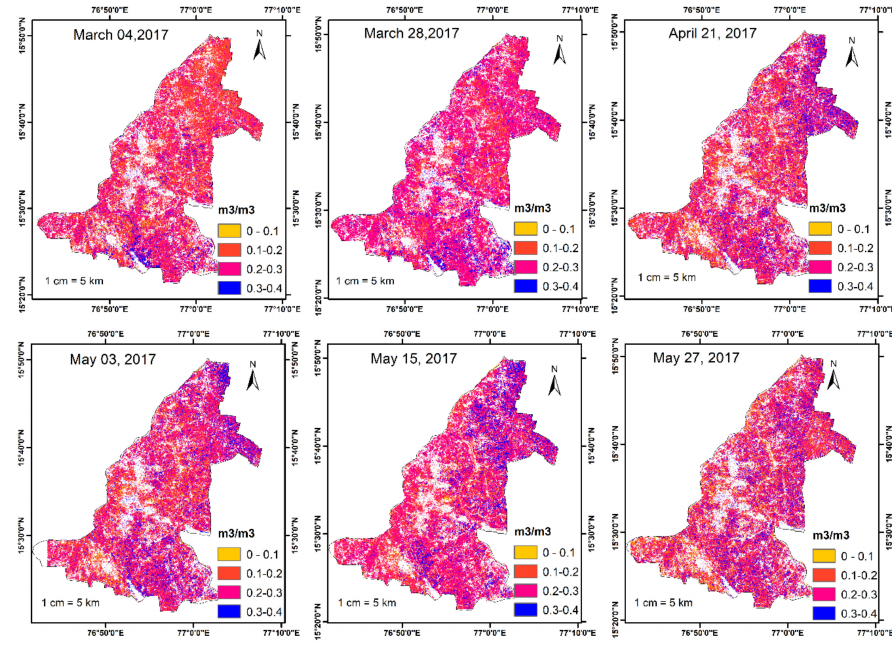
Figure 9. Spatial variability in the soil moisture in Siruguppa taluk during 2017.